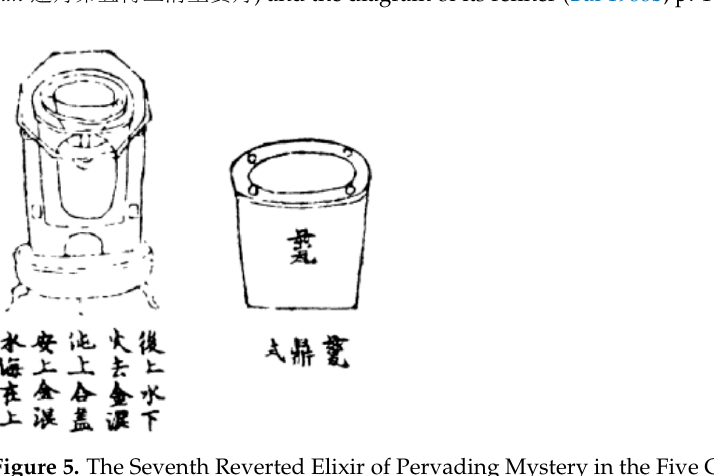
Figure 6. Picture of Zeng 甑 (Bai 1988b, p. 162a). Jinhua chongbi danjing mizhi shows that Bai Yuchan inherited the achievements of outer alchemy and “decorated” ( 修飾 ) them with his theories of inner alchemy (Meng 1993, p. 286). In other scriptures, Bai’s definitions on the tripod are all from the angle of inner alchemy, such as: Water source then soil crucible, crucible then golden tripod, golden tripod then jade furnace, jade furnace then sacred chamber, sacred chamber then core altar 水源即土釜，土釜即金鼎，金鼎即玉炉，玉炉即神室，神室即元坛 (Bai 2013a, p. 168). To refine the form, the cultivator has to use the body as the state, use the heart as the emperor, and use the essence as the people. The form is the furnace, and the head of the cultivator is the tripod. Because the head is full of the essence, it must be refined by fire 鍊形，以身為國，以心為君，以精為民。形者，鑪也。首 者鼎也。精滿於腦，故用火鍊 ( Zazhu zhixuan pian 1988, p. 614; Bai Xiansheng Qiongguan Zazhu Zhixuan Ji 1271, p. 3.4a). The first reference comes from Gousuo lianhuan jing 钩锁连环经 , which was gathered in Haiqiong chuandao ji 海瓊傳道集 (DZ1309) by Hong Zhichang 洪知常 , in the Southern Song dynasty. This scripture quotes Taiyi Yuanjun 太乙元君 to illustrate the procedures of cultivating the elixir in body and mind. The word “ ji 即 ” denotes the next step in the